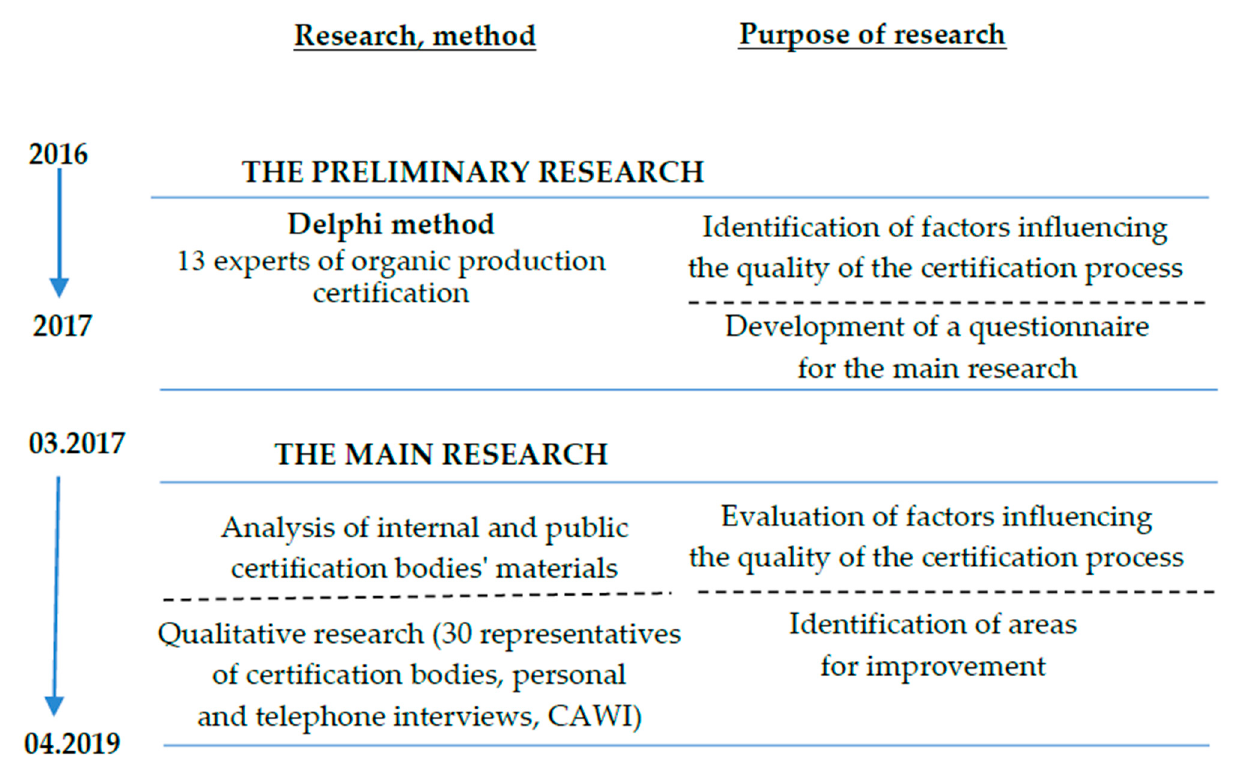
Figure 1. The research, method, and the purpose of research specification. Source: Data compiled by the authors.